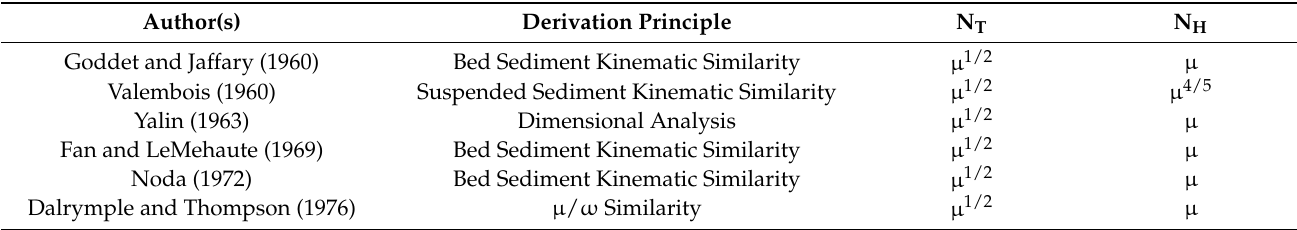
Table 1. Distorted scale ratios of physical quantities for mobile-bed test from the literature.